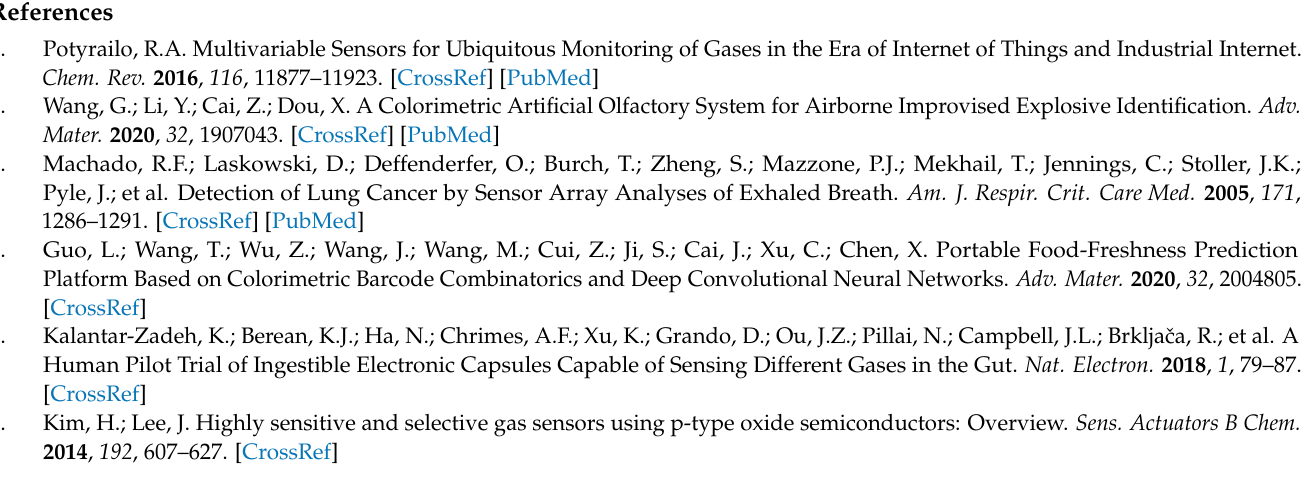
temperature; Figure S5: The sensor’s response to 1.25 ppm NO 2 was tested under relative humidity ranging from 0 to